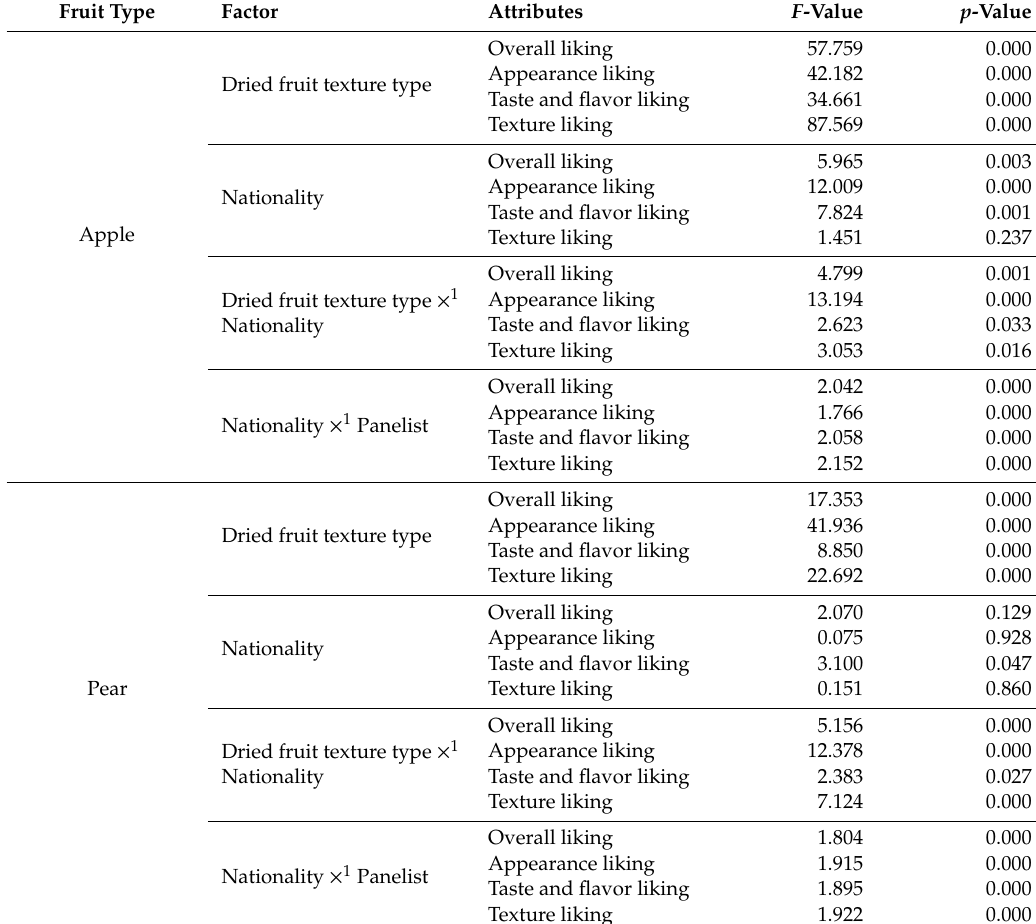
Table A1. F - and p - values associated with statistical significance for dried fruit texture types on the liking ratings of apple and pear chip